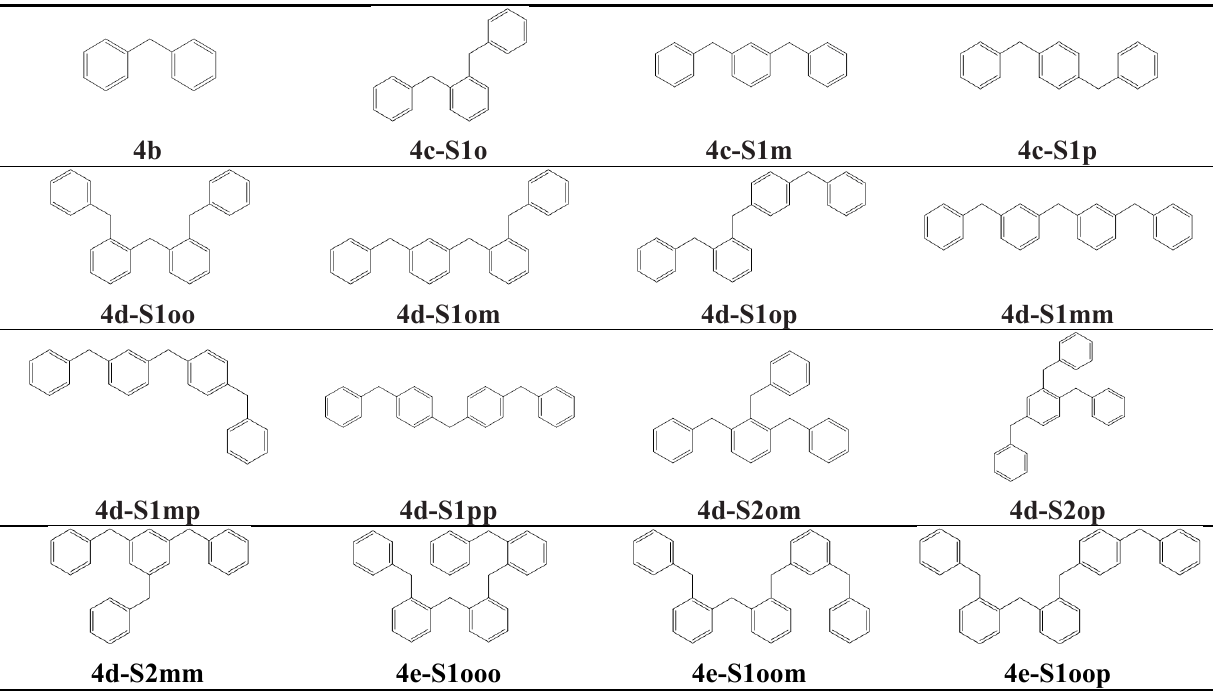
Table 4. Structure of model compounds: dimer, trimer, tetramer and